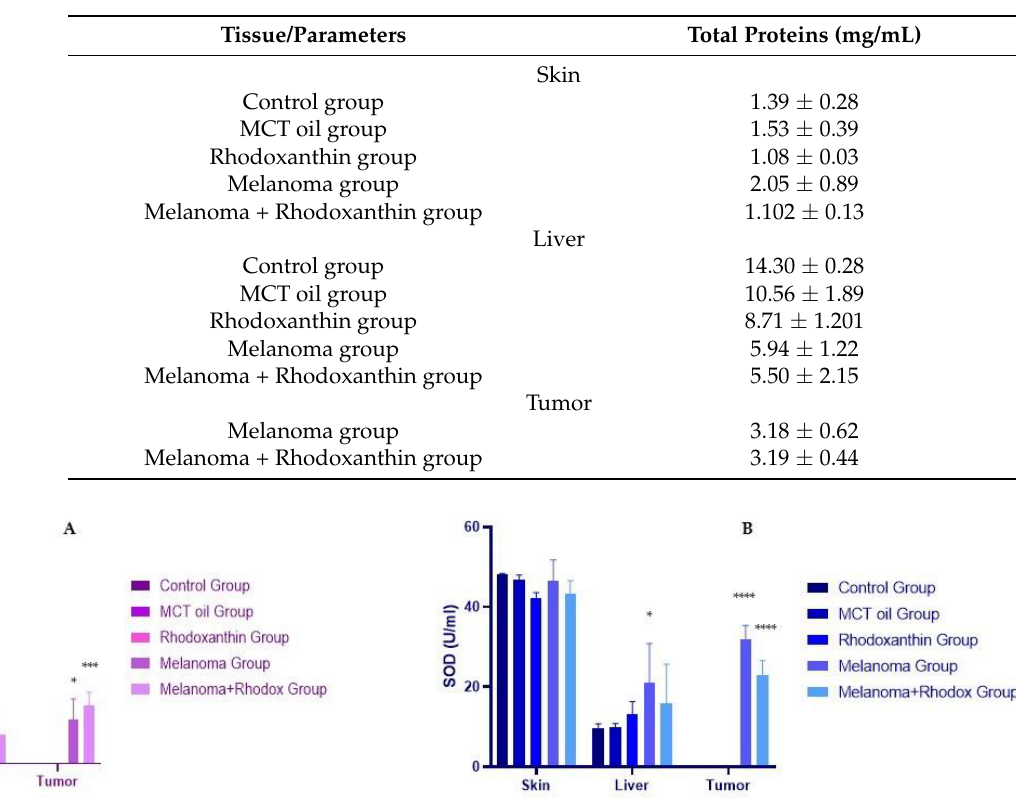
Table 2. Total protein evaluation of tissues.